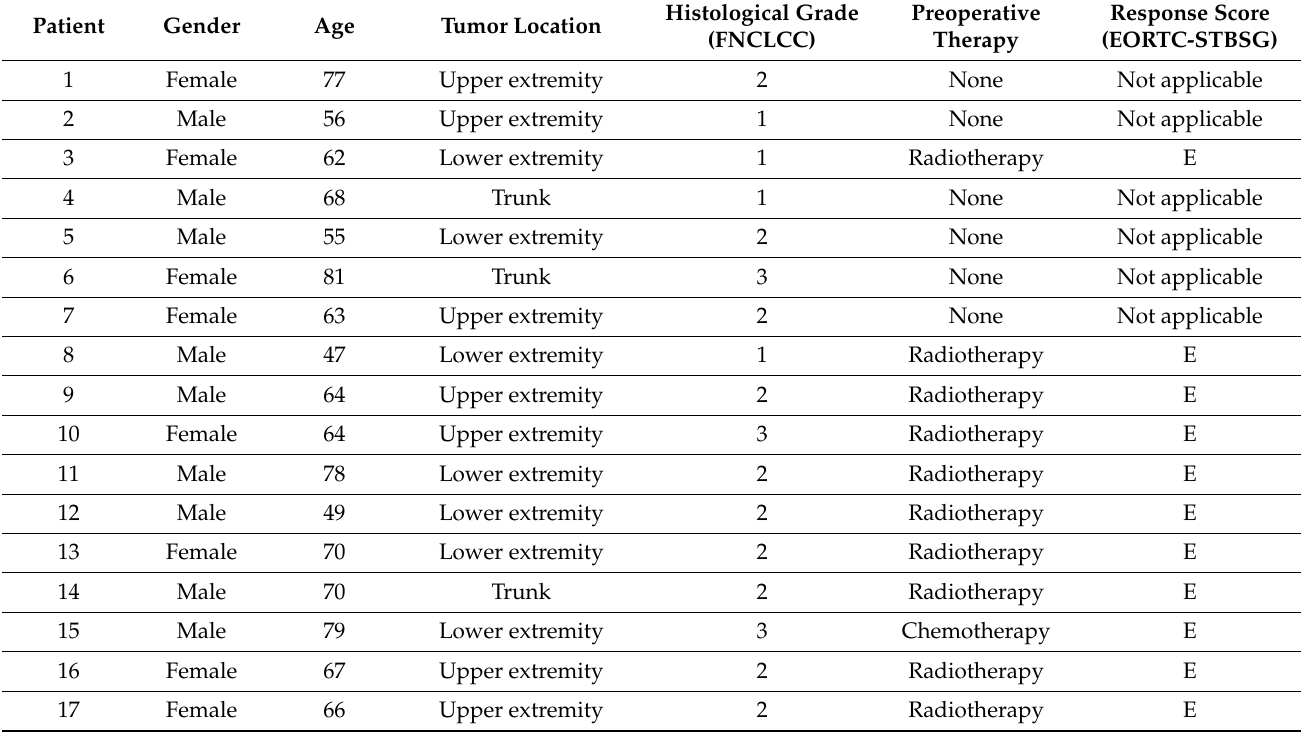
Table 1. Patient and tumor